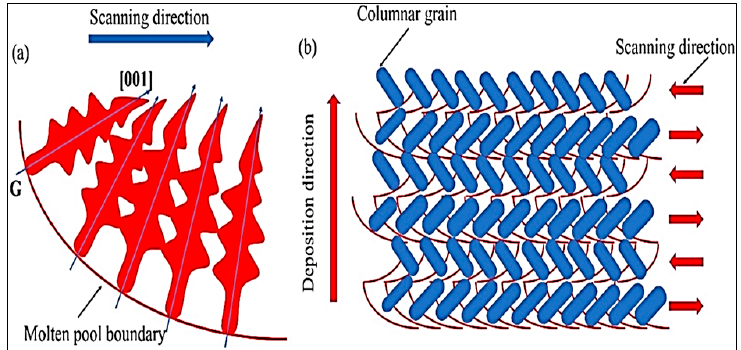
Figure 16. ( a ) Schematic diagram of dendritic growth in the molten pool; ( b ) Schematic diagram of columnar grains in the as-deposited sample (adapted with permission from Ref. [32] 2021, Elsevier).